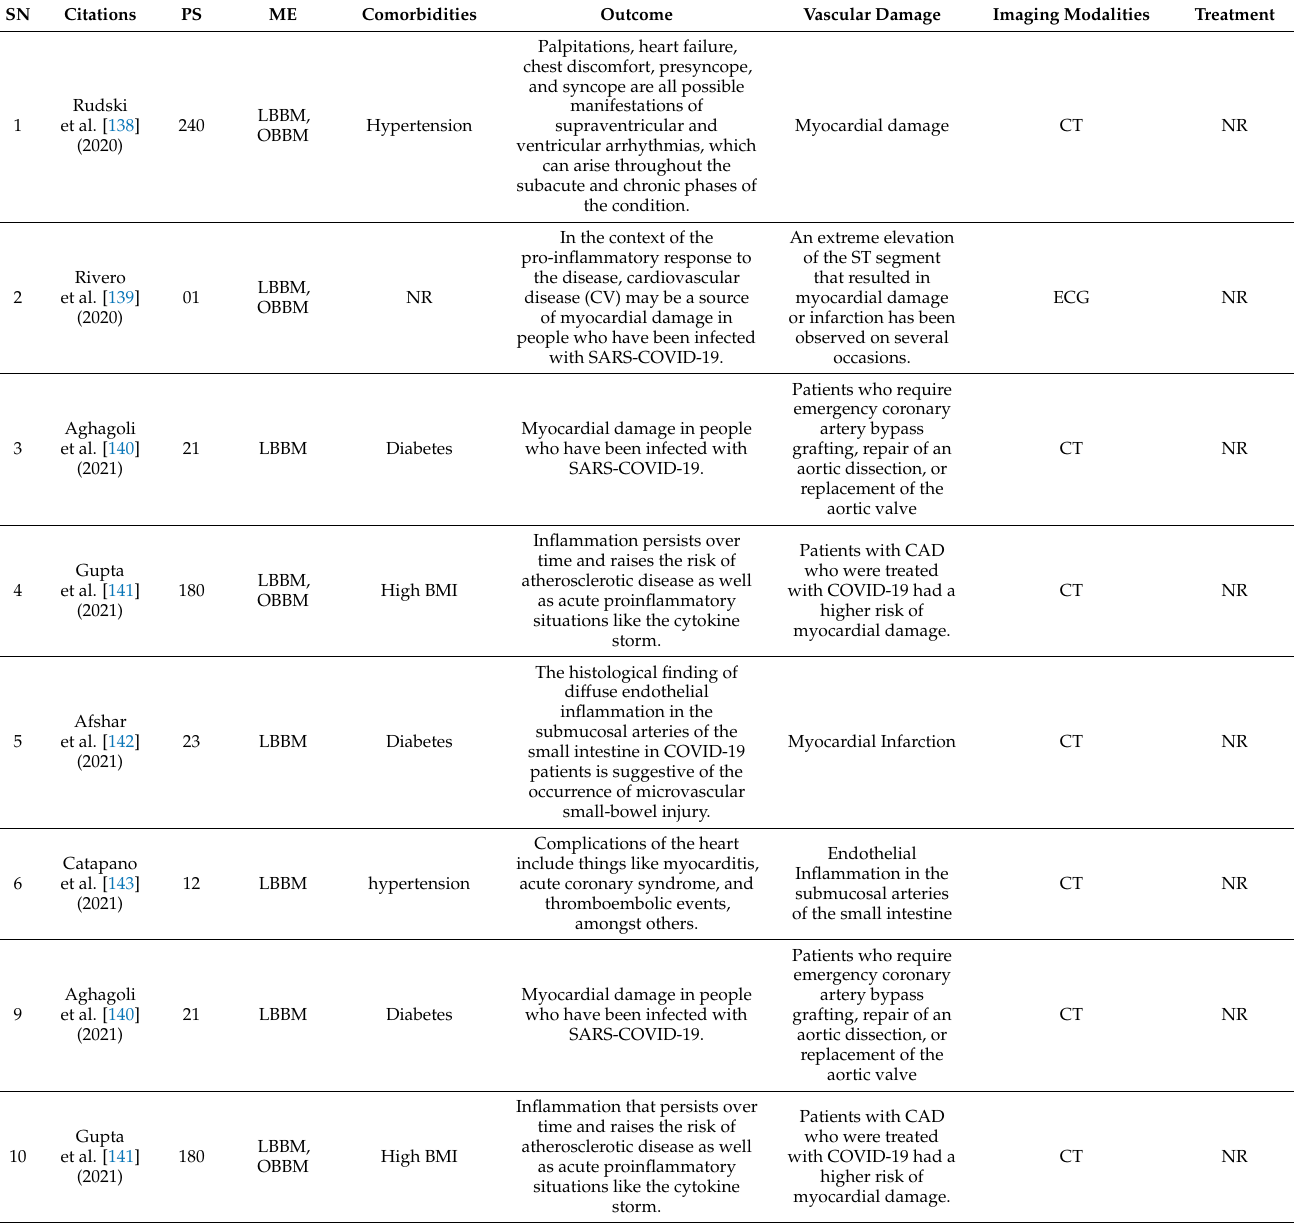
Table 3. The effect of COVID-19 on the coronary